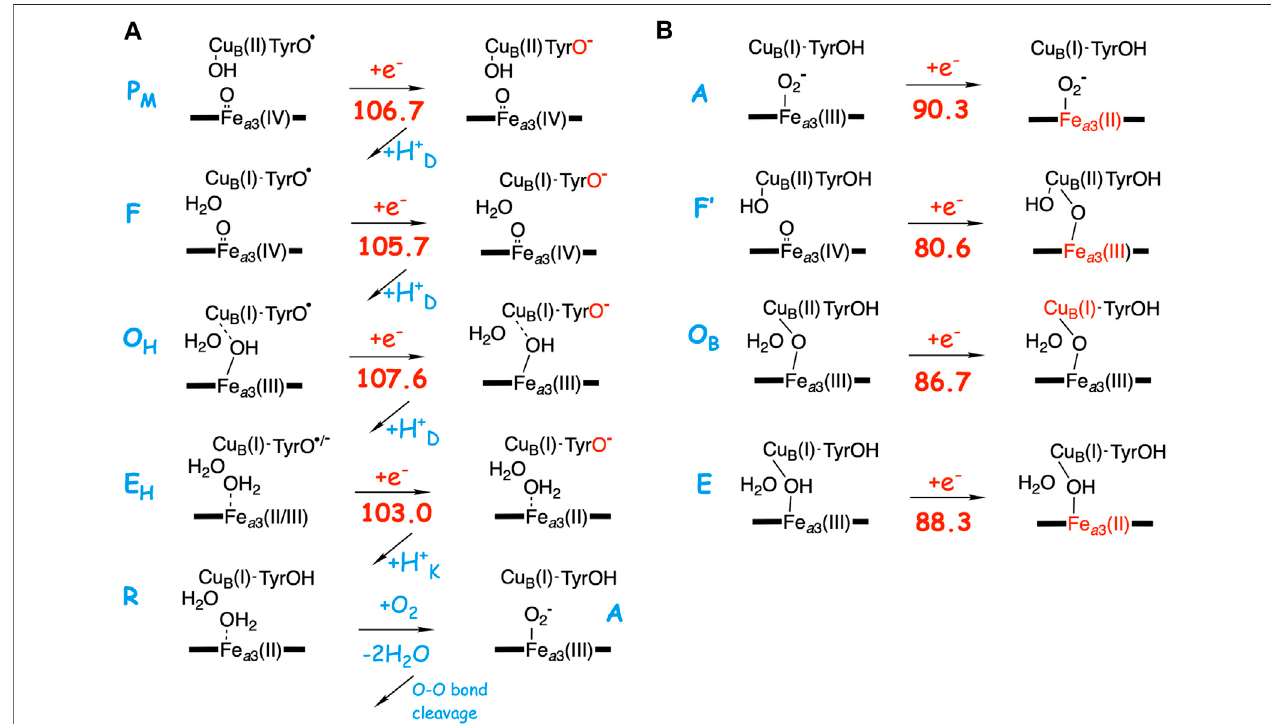
FIGURE 4 | Calculated electron af fi nities (EA, kcal/mol) of possible intermediates in the catalytic cycle of the A-family C c Os. (A) The mechanism for O 2 reduction suggested in Table 2 with calculated EAs for the intermediates that initiate each of the reduction steps. (B) Calculated EAs for alternative structures for each reduction step.